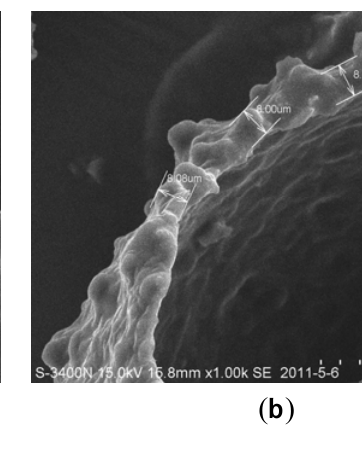
Figure 4. Shell thickness of organic